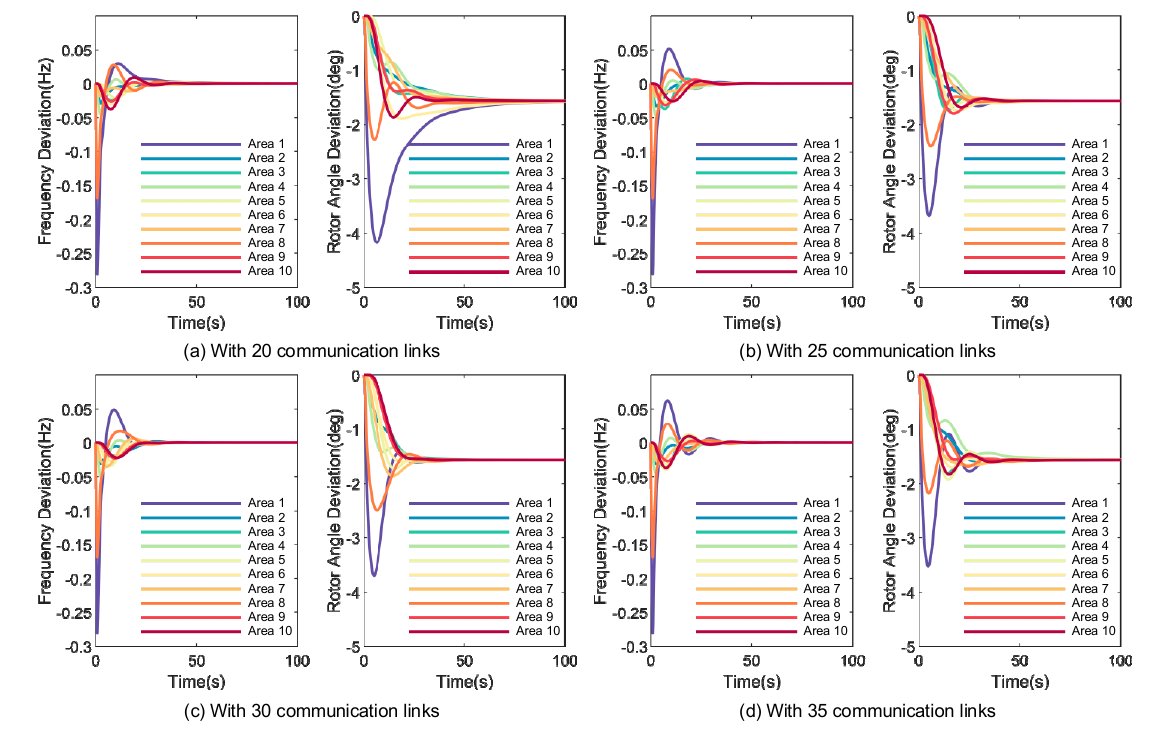
Figure 13. Frequency deviation and rotor angle deviation of the proposed method and the compared method with different numbers of communication links in frequency event G.